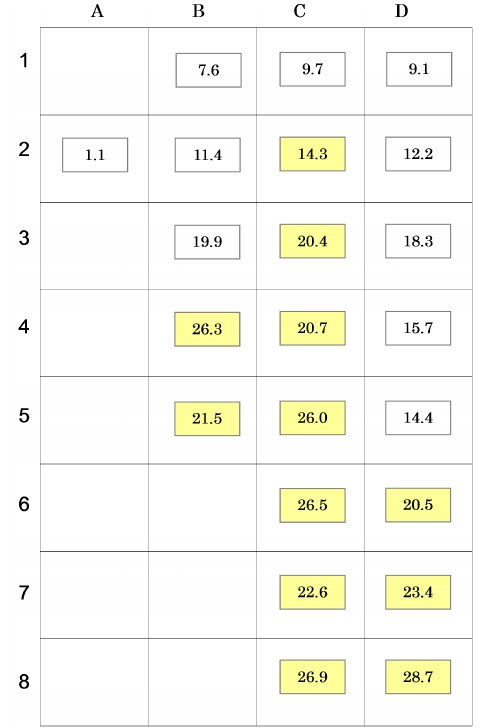
Figure 8. Average thickness of alluvial clay layer.